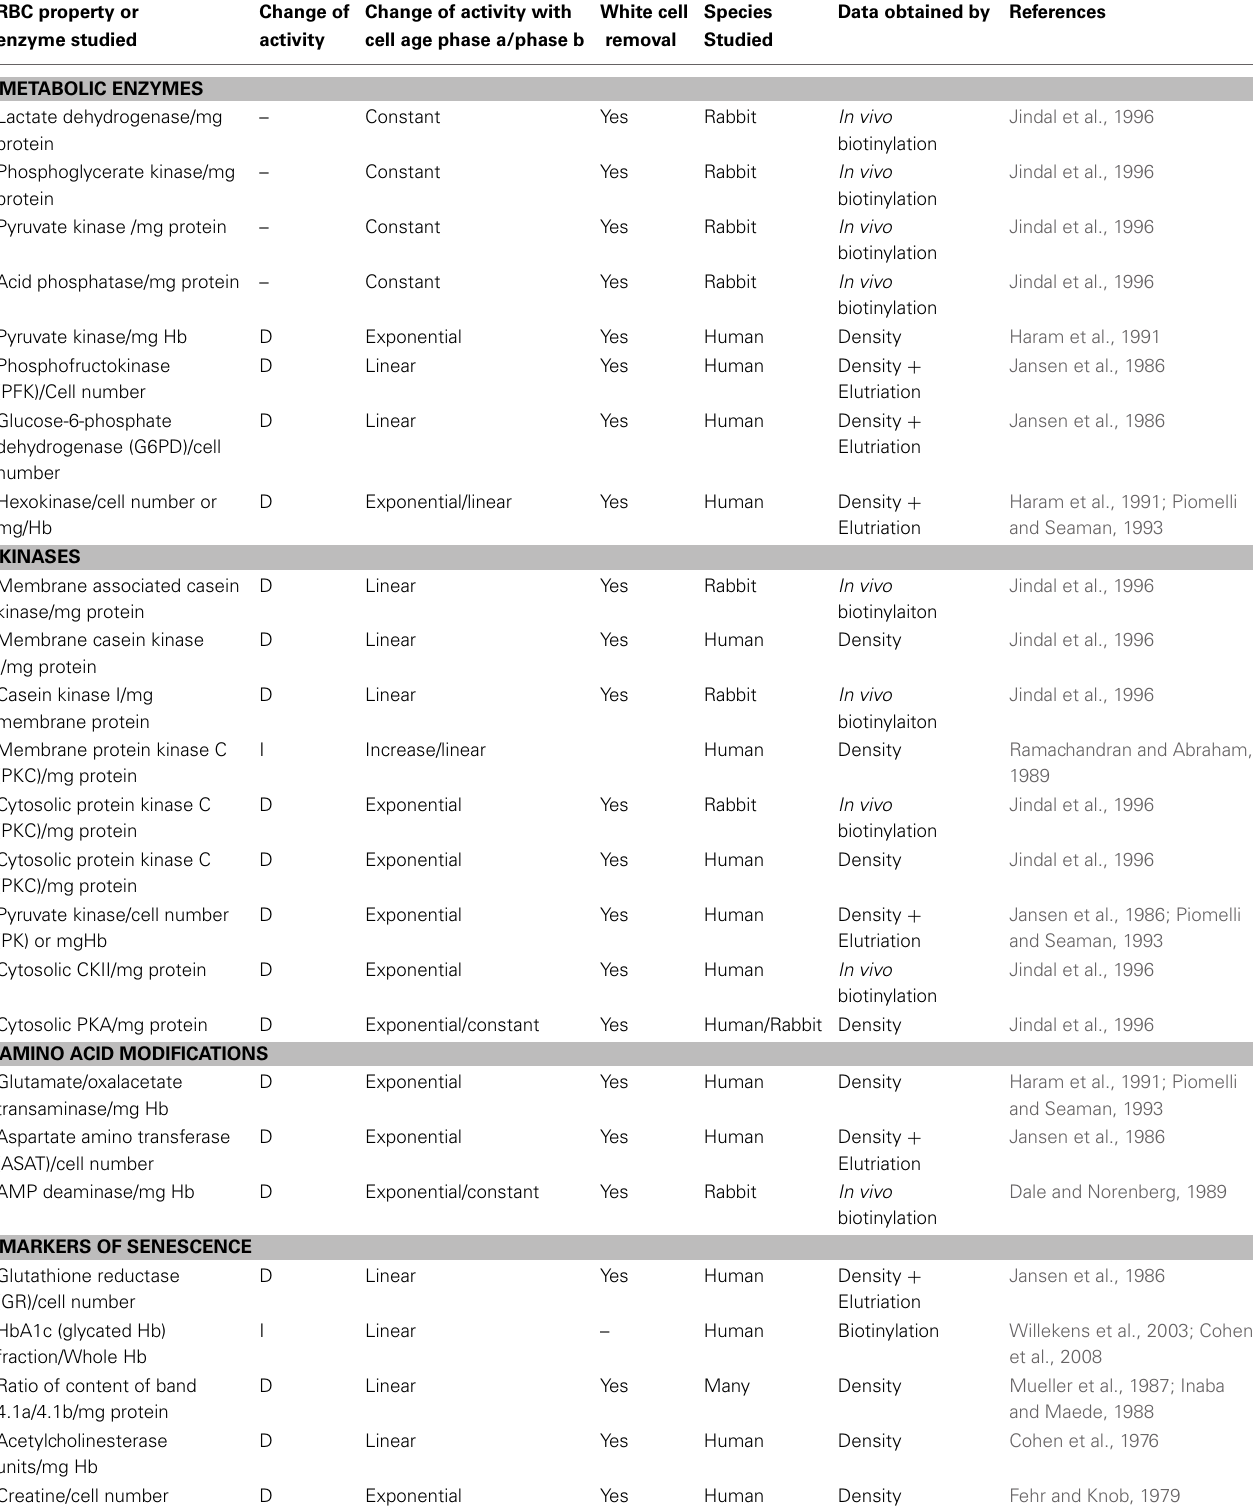
Table 1 | Changes in RBC properties associated with